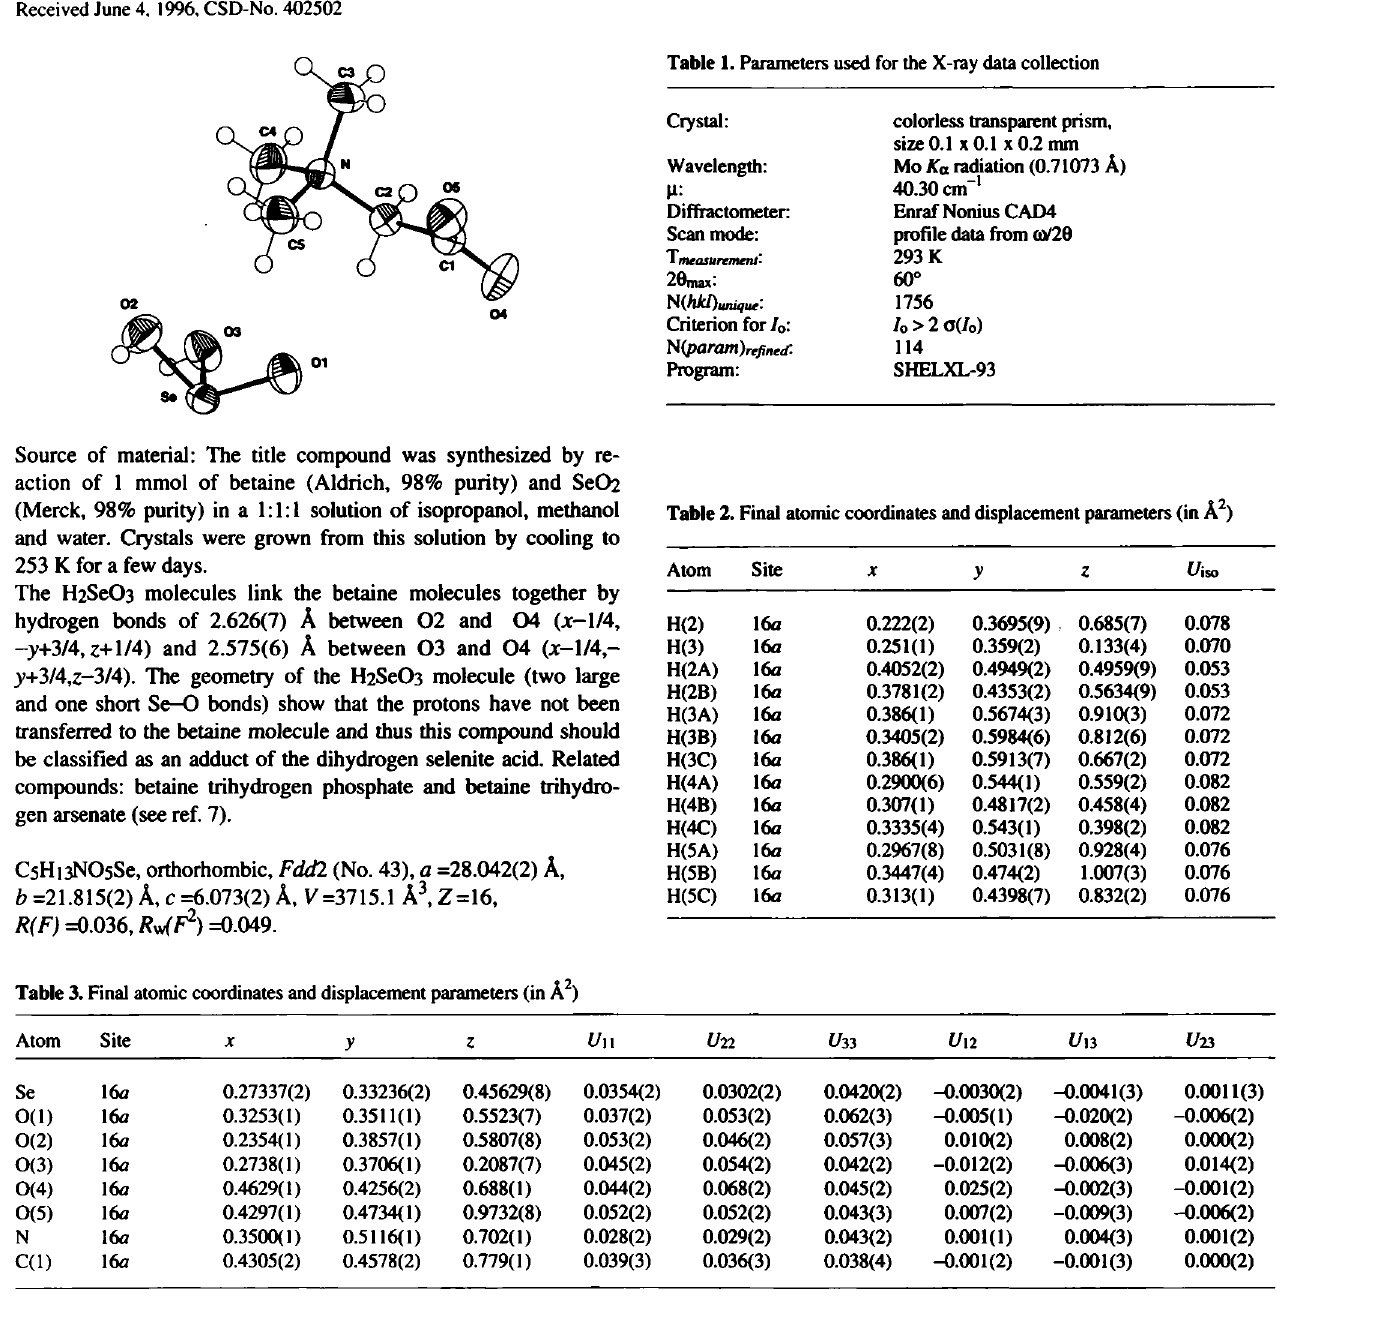
Table 1. Parameters used for the X-ray data collection Crystal: